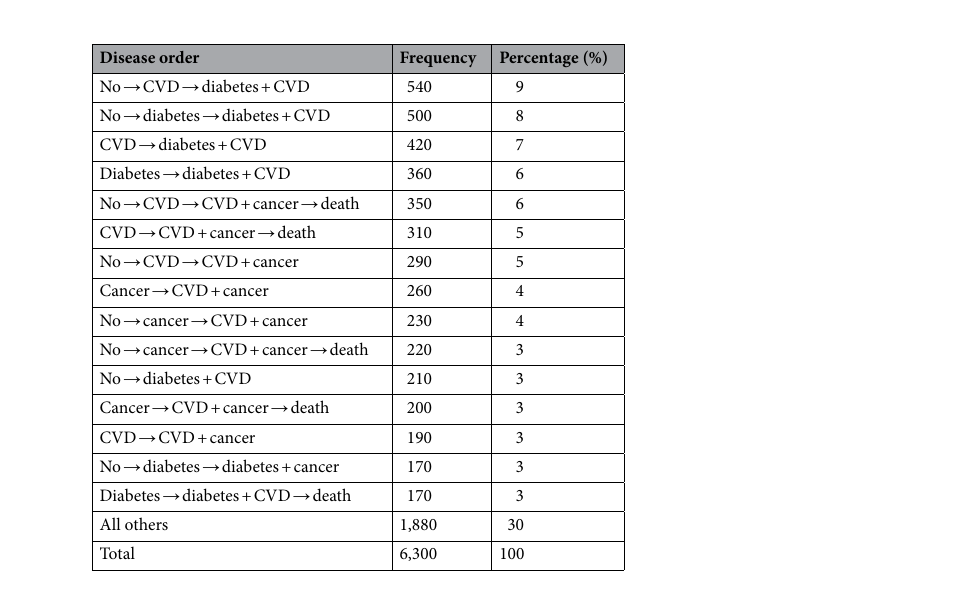
Table 2. List of 15 most common reduced sequences. Source: Scottish Longitudinal